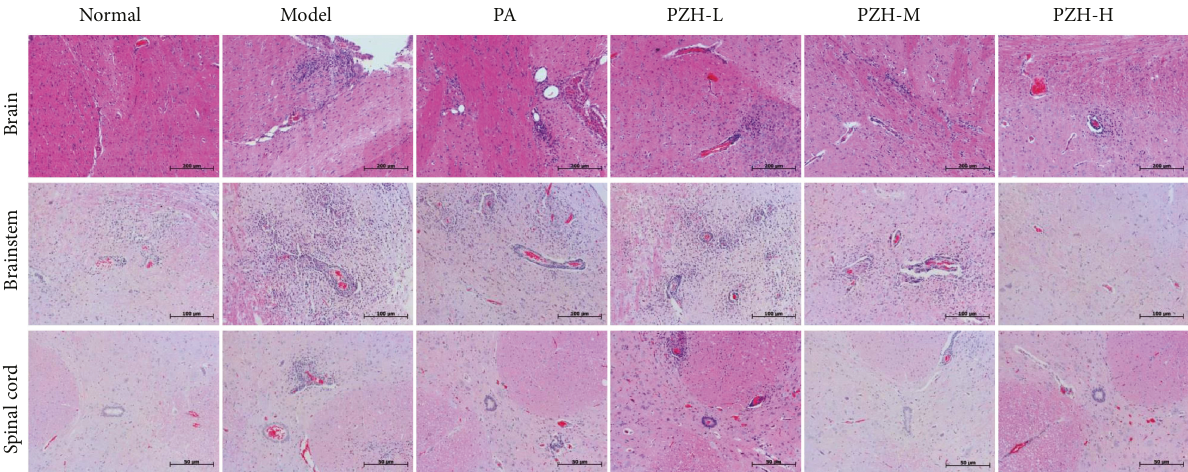
Figure 2: PZH ameliorated CNS in fl ammation in EAE rats. Rats were sacri fi ced at day 31, and the brain, brainstem, and spinal cord were harvested. In fl ammation of the brain, brainstem, and spinal cord was analyzed by H&E